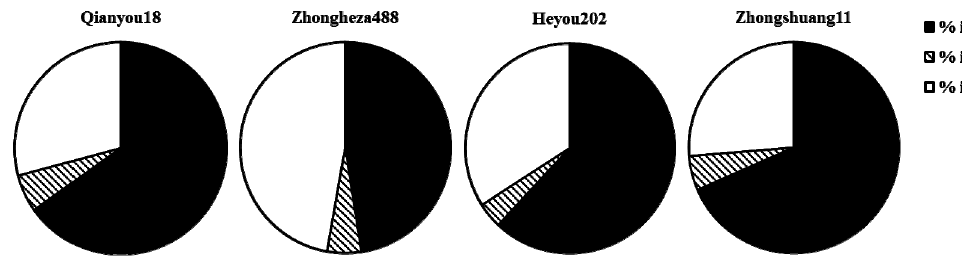
Figure 4. The percentages of different activities in relation to the complete probing of B. brassicae on oilseed rape during 6-hour electropenetrography (EPG) experiments. The % in C represents the percentage of probing spent in the pathway; the % in E1 represents the percentage of probing spent in salivation; the % in E2 represents the percentage of probing spent in sap ingestion.